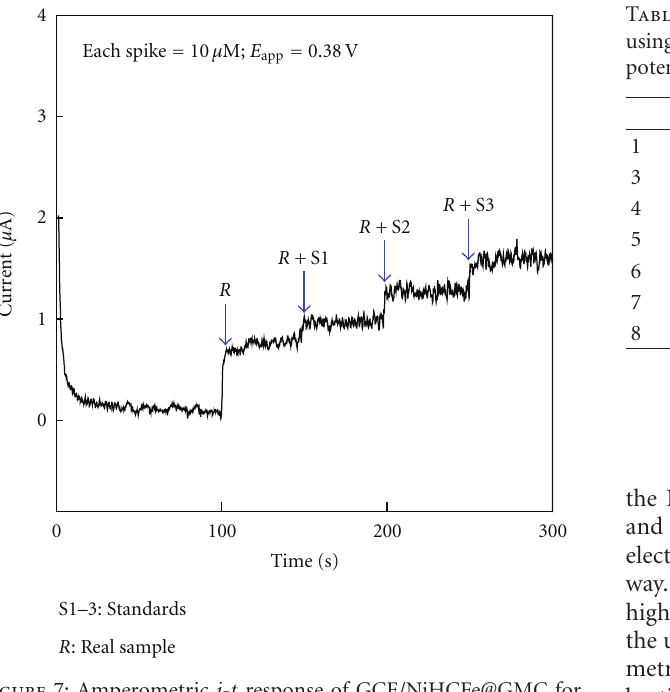
Figure 7: Amperometric i-t response of GCE/NiHCFe@GMC for the analysis of hydrazine in cigarette smoke dissolved pH 7 PBS at an applied potential of 0.38 V versus Ag/AgCl.